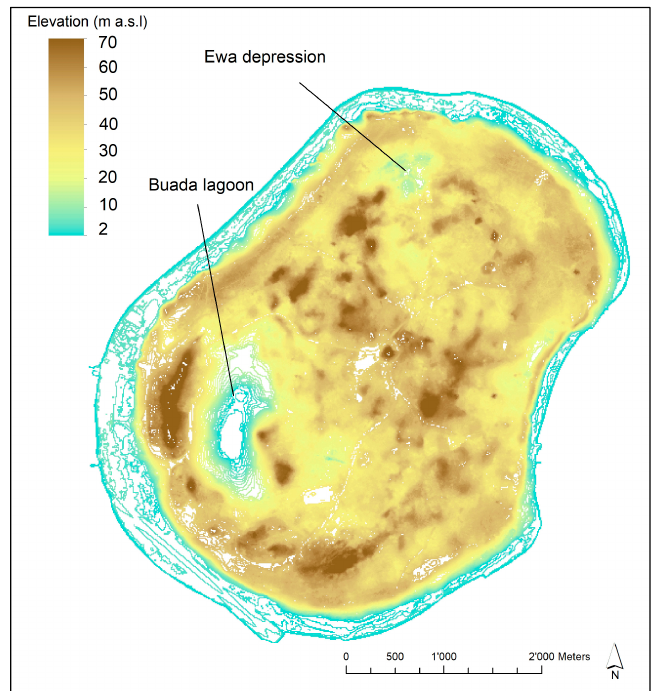
Figure 4. DTM elaborated by Politecnico di Milano with the data of the photogrammetric aerial survey carried out in 2010. Bottomside, cyan; and Topside, brown .